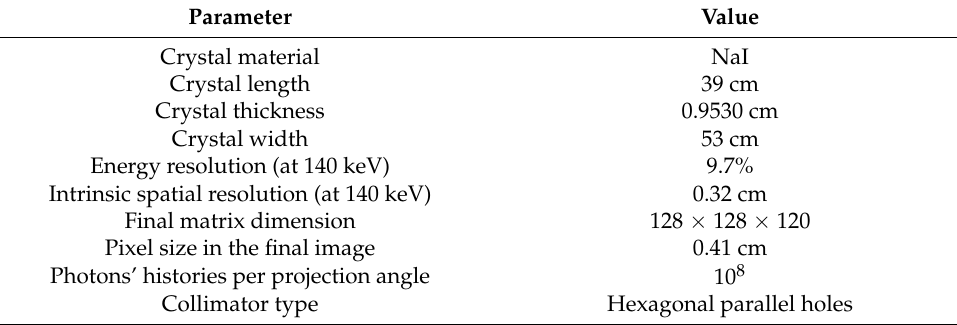
Table 1. Main parameters set for the SPECT